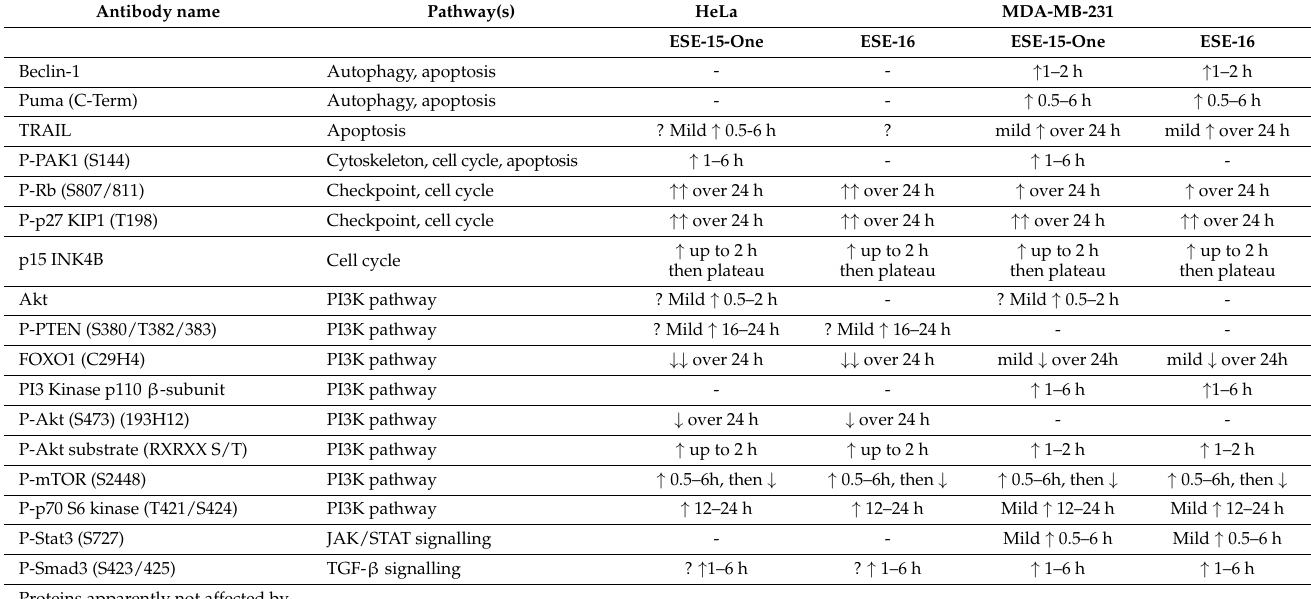
Table 1. RPPA results indicating the temporal involvement of potential signalling pathways in response to ESE-15-one and ESE-16 exposure to HeLa and MDA-MB-231 cells for 24 h. Indicated is the antibody tested, the pathway involved, and the visual trend observed in expression. ( ↑ indicates increase; ↑↑ more pronounced increase; ↓ decrease; ↓↓ more pronounced decrease; - no change from control; ? indicates possibility/unconvincing